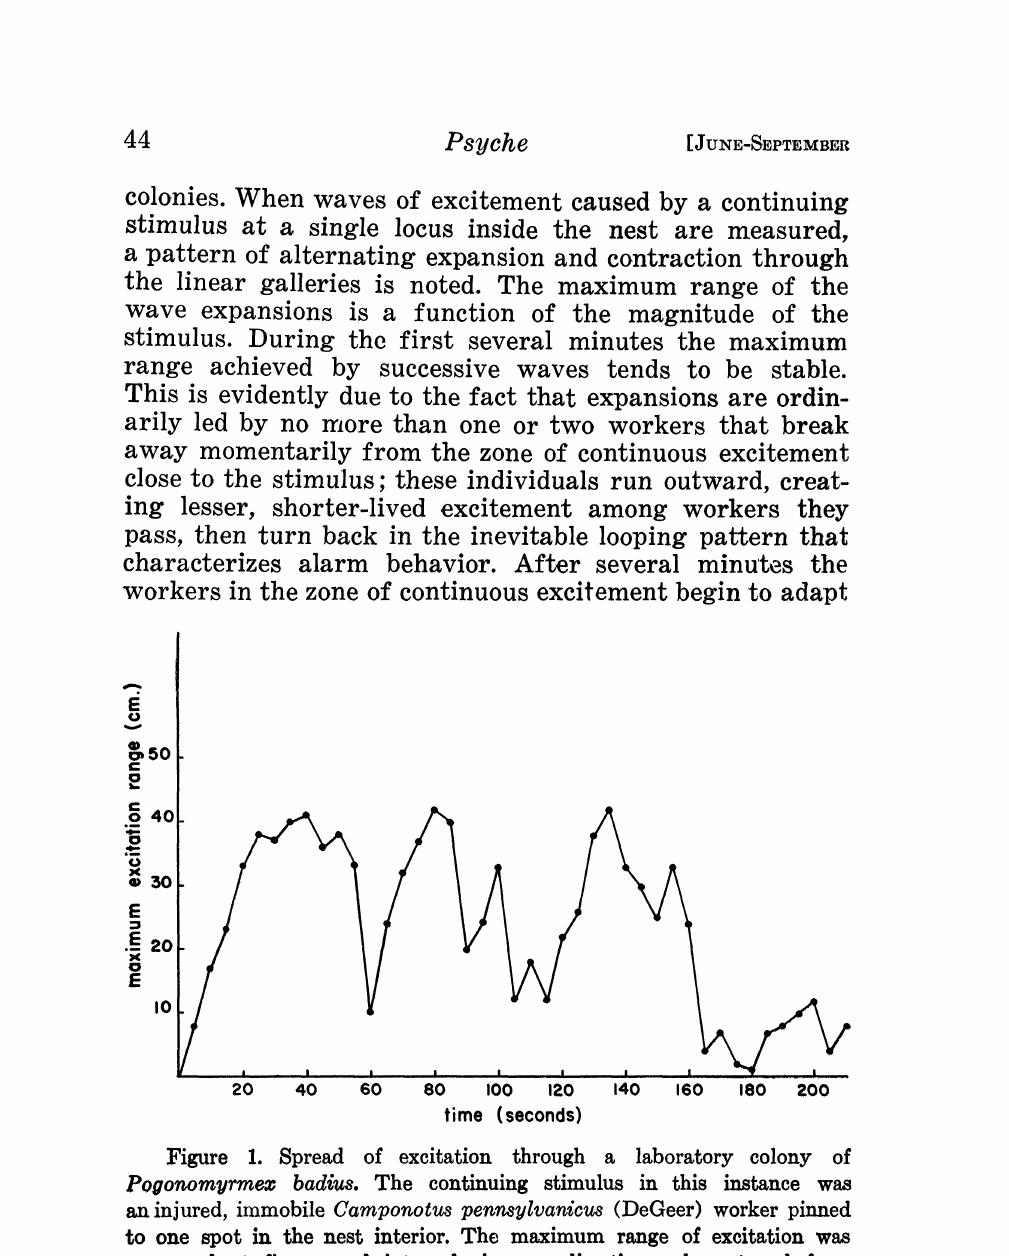
Figure 1. Spread of excitation through a laboratory colony of Pogonomyrmer, bad,us. The continuing stimulus in this instance was an injured, immobile Camponotus pennylvanicus (DeGeer) worker pinned to one spot in the nest interior. The maximum range of excitation was measured at five-second intervals in one direction only outward from the stimulus through the linear galleries of the artificial nest. Nest temperature" 30 -+- 2 C. Further explanation in the